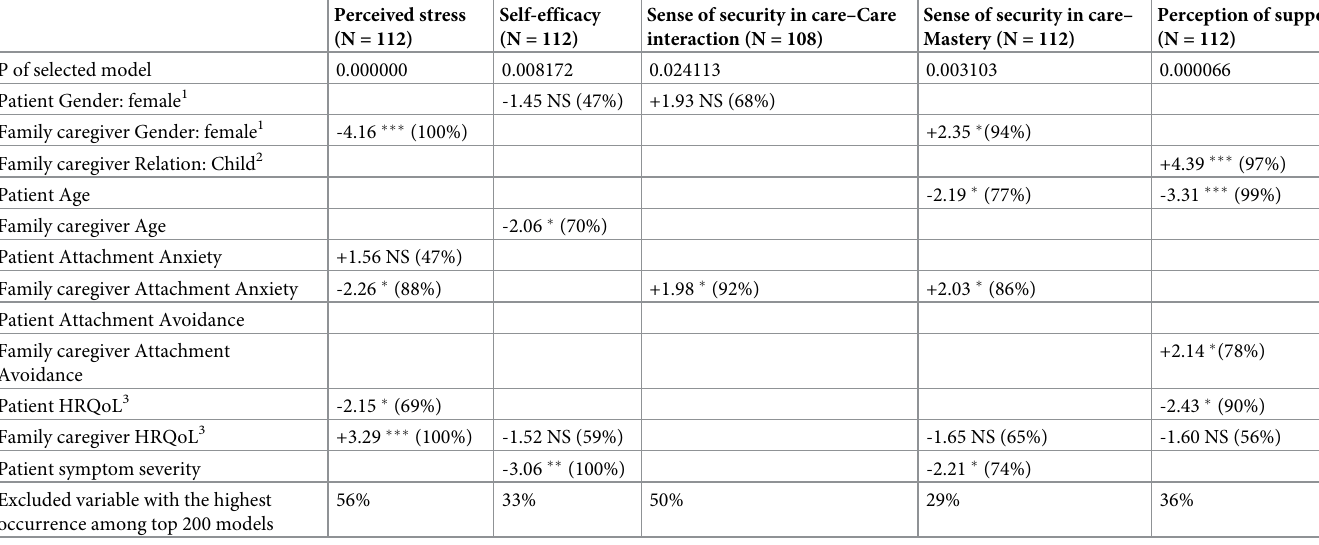
Table 4. The best selected model for each the five response variables under